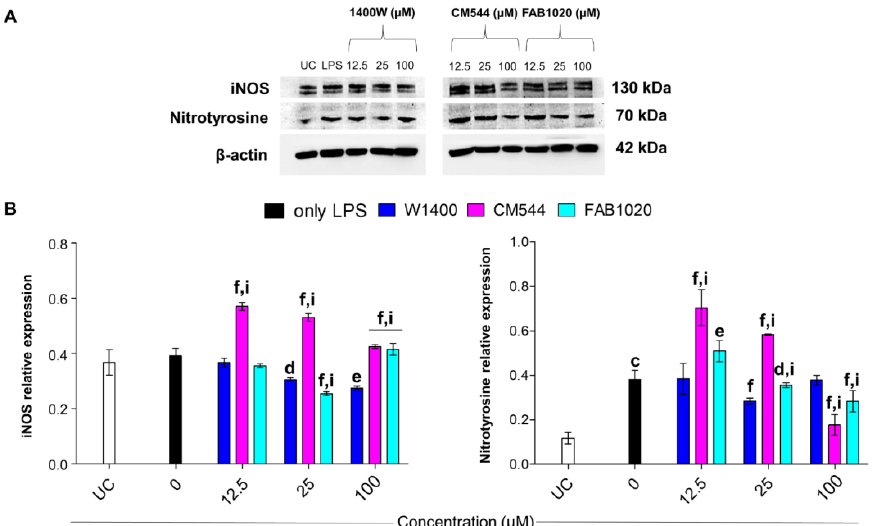
Figure 6. iNOS and nitrotyrosine protein expression in LPS ‐ stimulated human monocytes in the presence of increasing concentrations of 1400W, CM544 and FAB1020 after 24 h. ( A ) Protein bands from a representative experiment. β‐ actin is used as a loading control. ( B ) Bar graphs display densitometric values expressed as mean densitometric optical intensities (D.O.I) normalized on those of the loading control. UC = untreated cells. c = p < 0.0001 between LPS ‐ stimulated cells and untreated cells. d = p < 0.01, e = p < 0.001 and f = p < 0.0001 between LPS ‐ stimulated cells and LPS ‐ stimulated cells treated with compounds; g = p < 0.01, h = p < 0.001 and i = p < 0.0001 between LPS ‐ stimulated cells treated with 1400W and LPS ‐ stimulated cells treated with CM544 and FAB1020 at the same concentration.